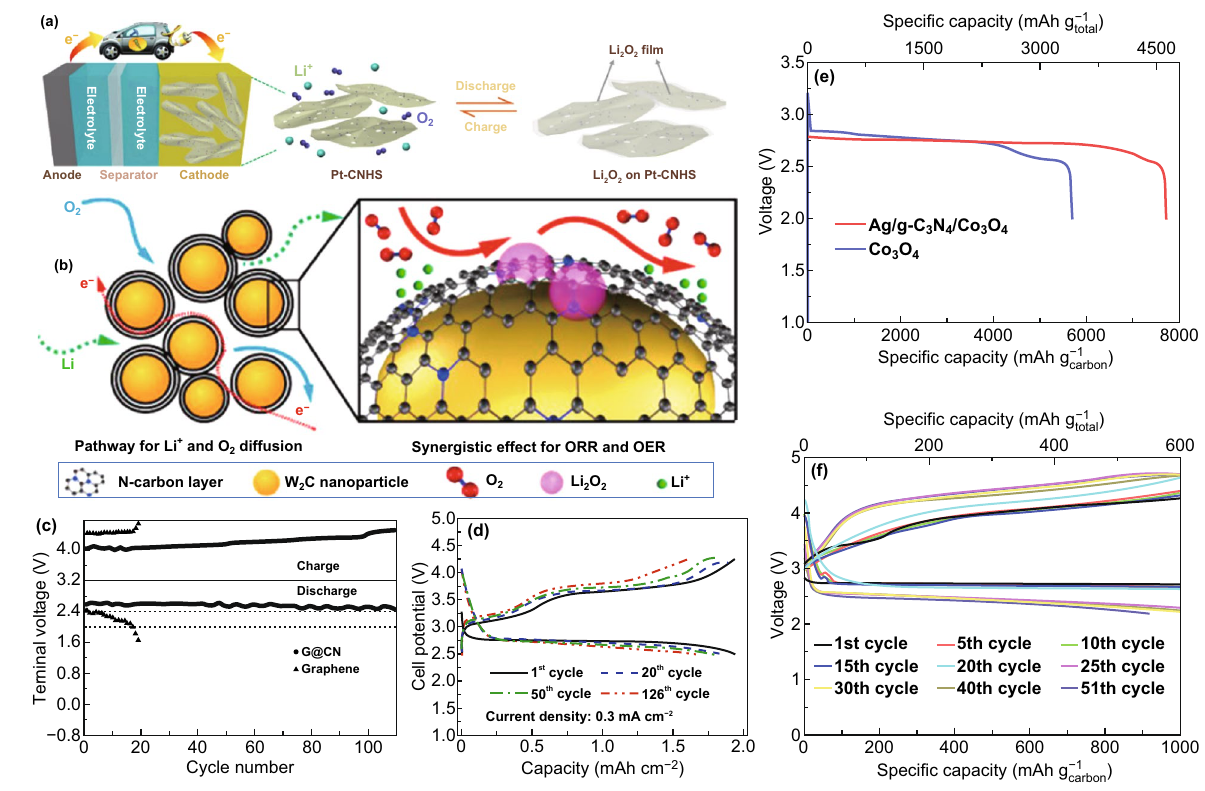
Fig. 24 a Schematic illustration for the reaction process during cycling. Reproduced with permission from Ref. [63]. b Schematic diagram of the synergistic effect of N-doped carbon layer and W 2 C nanoparticles as Li-O 2 battery catalyst. Reproduced with permission from Ref. [142]. c Comparison of the cycling performances of graphene and G@CN free-standing macroporous electrode. Reproduced with permission from Ref. [143]. d Cycle performance of RuO 2 @m-BCN in Li-O 2 batteries with a current density of 0.3 mA cm −2 . Reproduced with permission from Ref. [144]. e First discharge curves of Co 3 O 4 and Ag/g-C 3 N 4 /Co 3 O 4 as catalysts at a current density of 100 mA g −1 f First charge/discharge curves of the